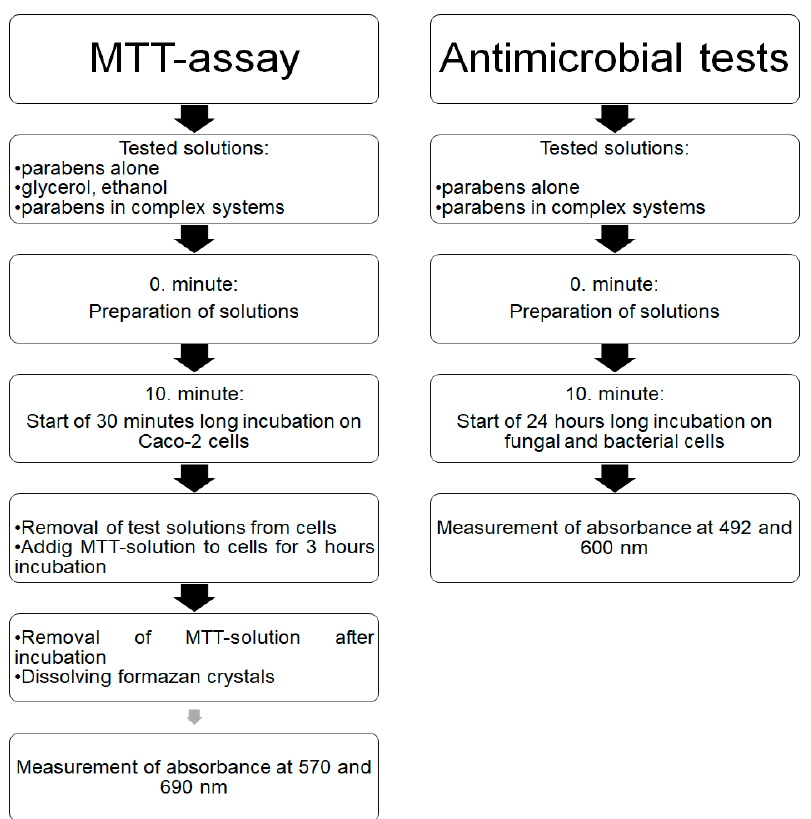
Figure 2. Experimental design. Table 1. Composition of test solutions for cytotoxicity tests.